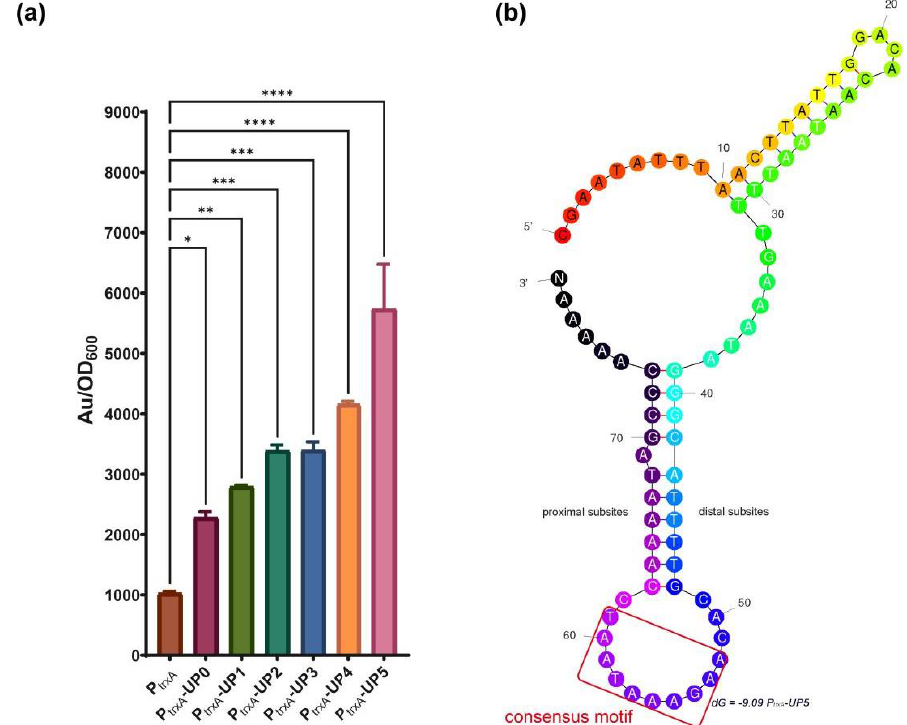
Figure 5. Expression strength of the synthetic promoters with different lengths in flanking base pairs. ( a ) Expression strength was compared by the florescent method, using wild-type P trxA as the control. ( b ) The predicted structure of UPL. Au — Arbitrary unit. Results are expressed as mean of replicates; columns with ****, ***, ** or * represent statistically significant differences between groups at p < 0.0001, p < 0.001, p < 0.01 or p < 0.05, respectively.